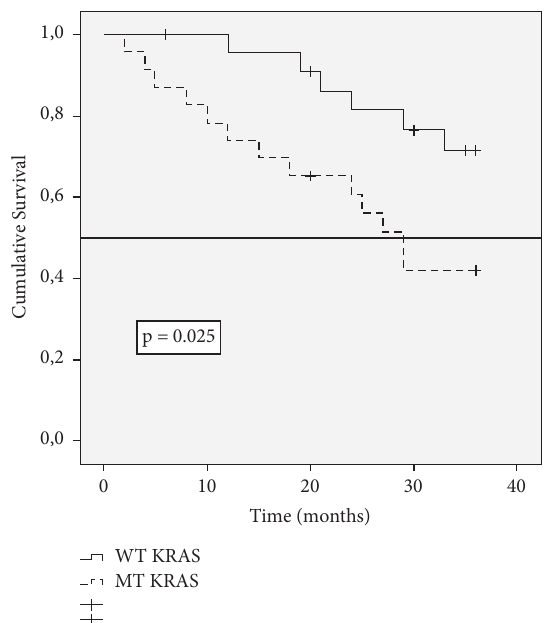
Figure 2: Kaplan–Meier survival function curve in patients with PCI 1–10 according to KRAS mutation status. The horizontal bar denotes median survival.